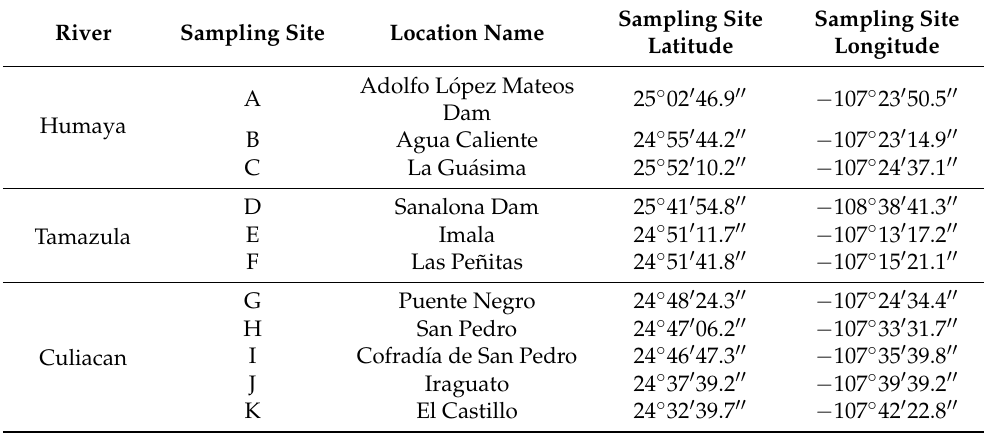
Table 1. Latitude and longitude coordinates of each sampling site for the recovery of water from the Humaya River, Tamazula River, and Culiacan River in northwestern Mexico. River Sampling Site Location